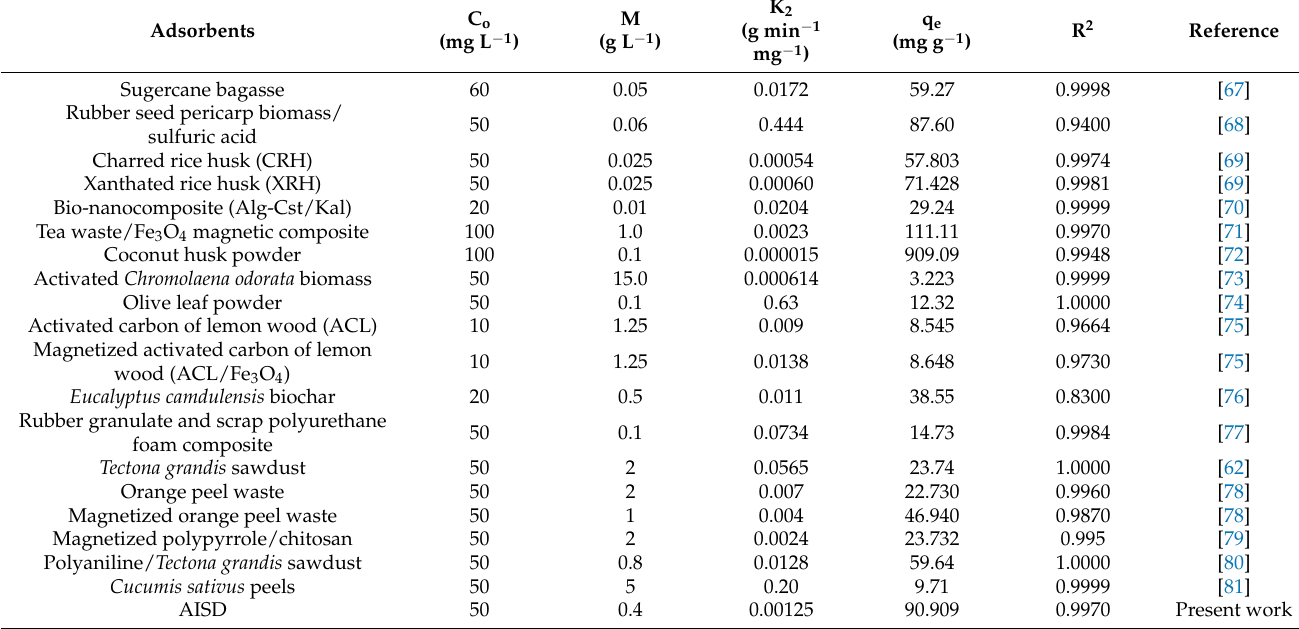
Table 2. PSOR parameters for adsorption of CV onto different